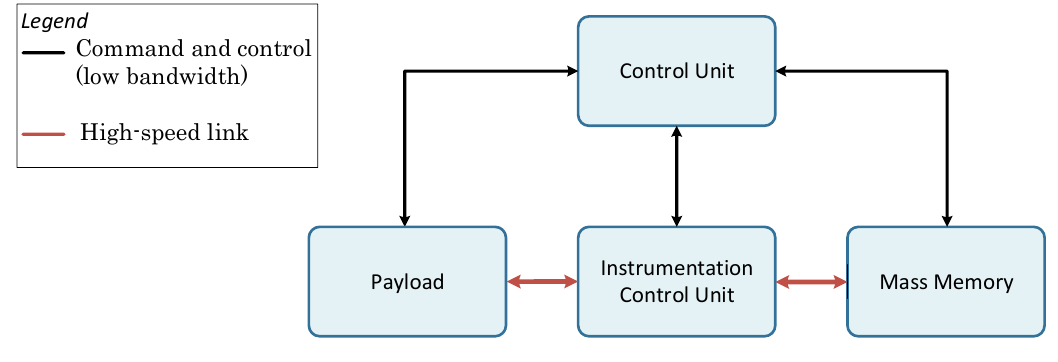
Figure 6. CubeSat on-board electronics architecture.